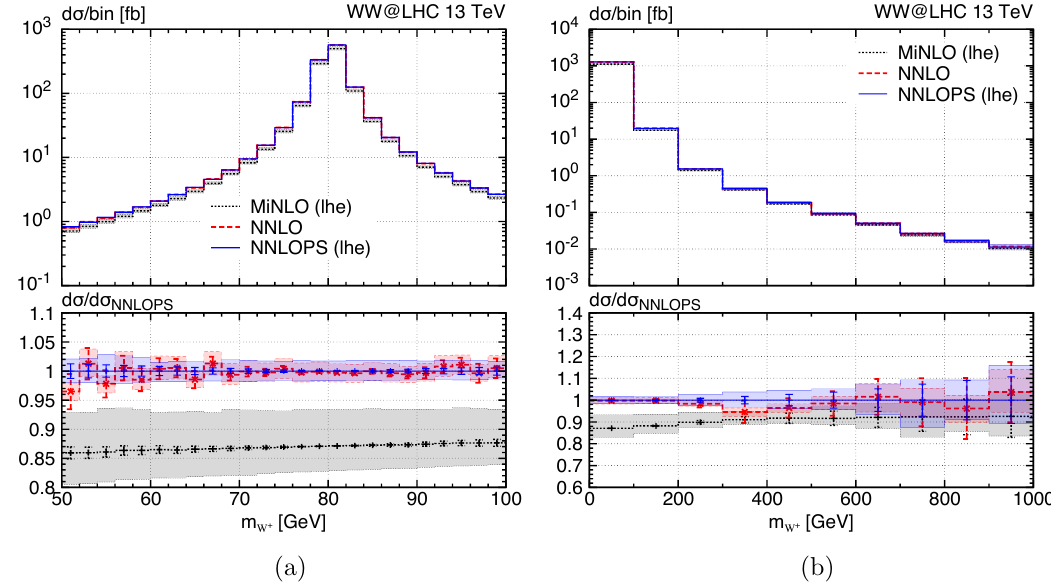
Figure 4 . Same as (cid:12)gure 2, but for the invariant mass of the W + boson m regions: (a) around the W -mass peak, m m 2 [0 ; 1000] W +